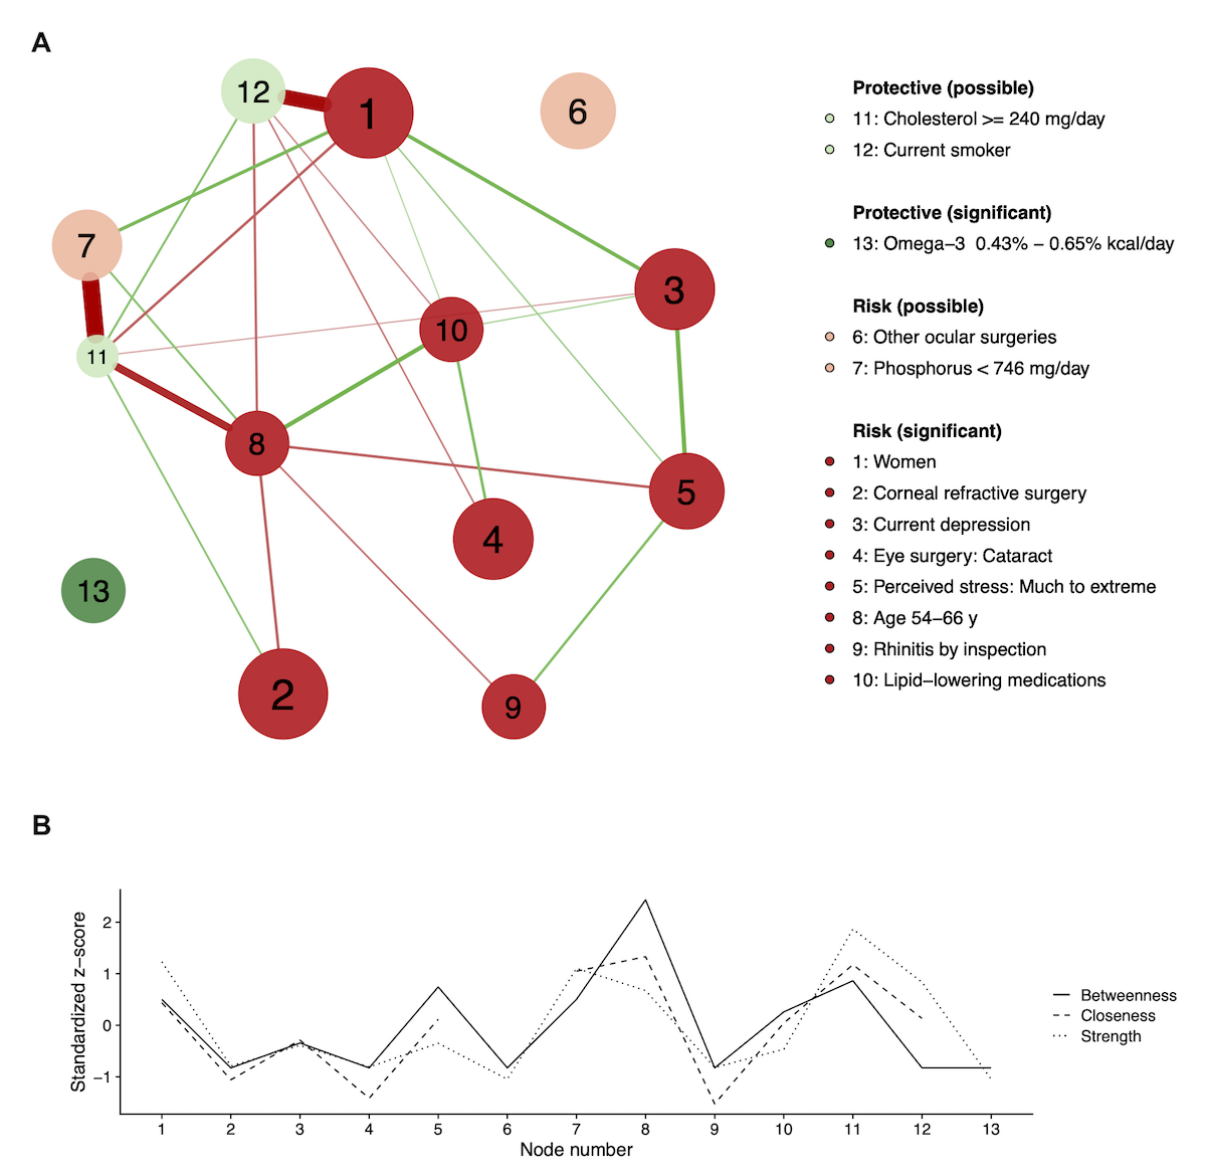
Figure 3. The partial correlation (adaptive LASSO) network (A) and the centrality indices (betweenness, closeness, and strength) (B) of the factors associated with the dry eye disease. Factors were positively (risk) or negatively (protective) associated with dry eye disease. Factors can be significant ( P <.05) or possible (P ≥ .05) according to the risk factor analysis. The node size is proportional to the absolute value of the point for the node’s variable. Green and red edges mean positive and negative connections, respectively. The edge with the highest absolute weight will have full color saturation and be the